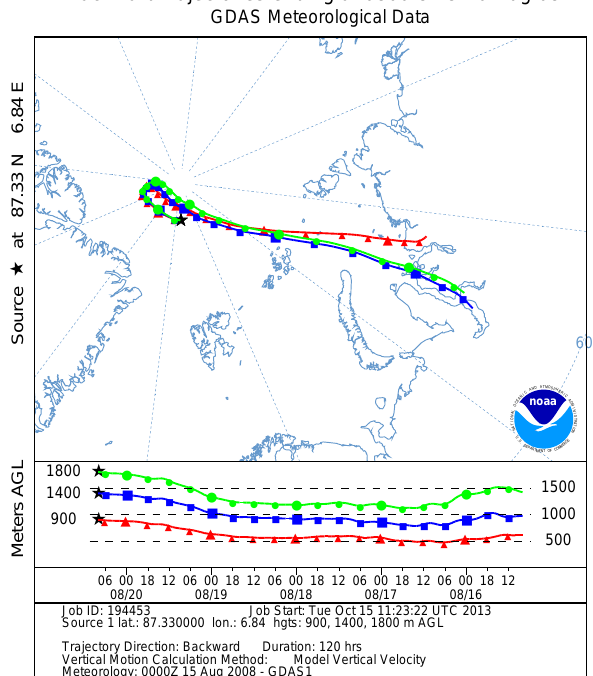
Fig. 13. Five-day backward air mass trajectory ending at 08:00UTC, 20 August 2008 at 87.33 ◦ N 6.84 ◦ E, calculated for 900m (red), 1400m (blue) and 1800m (green) receptor-point al- titude. Source: calculated using the HYSPLIT model http://www.